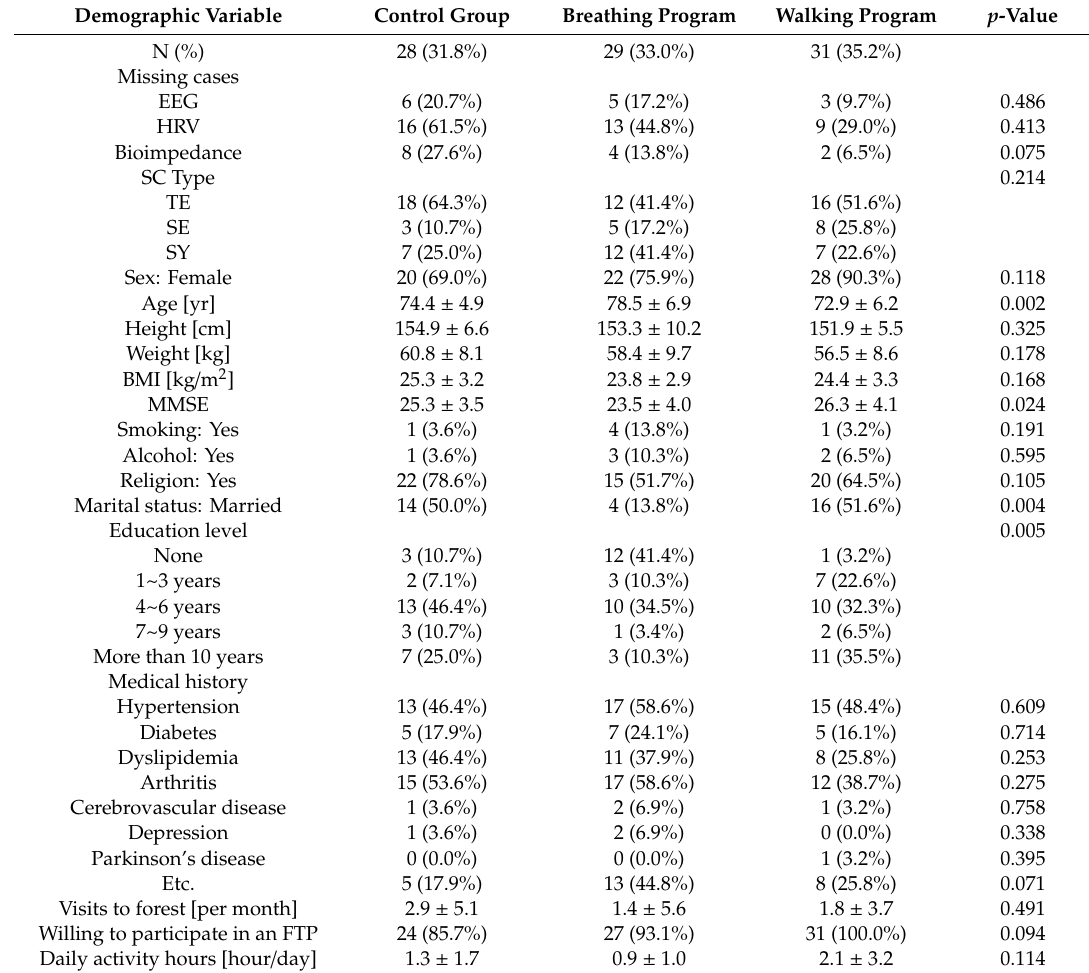
Table 2. Demographic information. SC, Sasang constitutional; HRV, heart rate variability; TE, Tae-Eum; SE, So-Eum; SY, So-Yang; MMSE, Mini Mental-Status Examination; BMI, body mass index; FTP, forest therapy